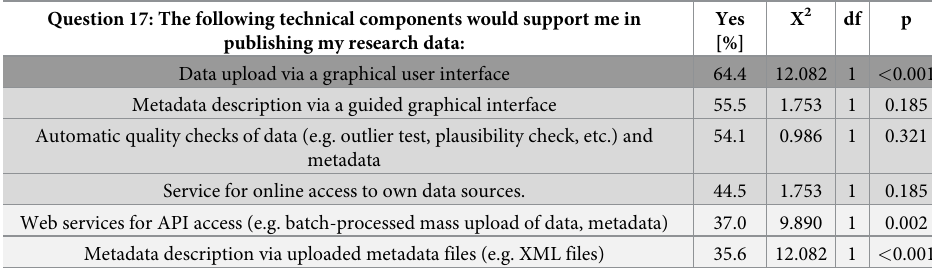
Answers given by data providers (N = 146) at question Q17 . X 2 -square tests were used to compare answers given, i.e. proportion of “yes” and “no” answers. Answer options with significantly more supporters (“yes”) are displayed in dark gray, with balanced answers (“yes” / “no”) are displayed in medium gray and answer options significantly more rejected ("no") are displayed in light